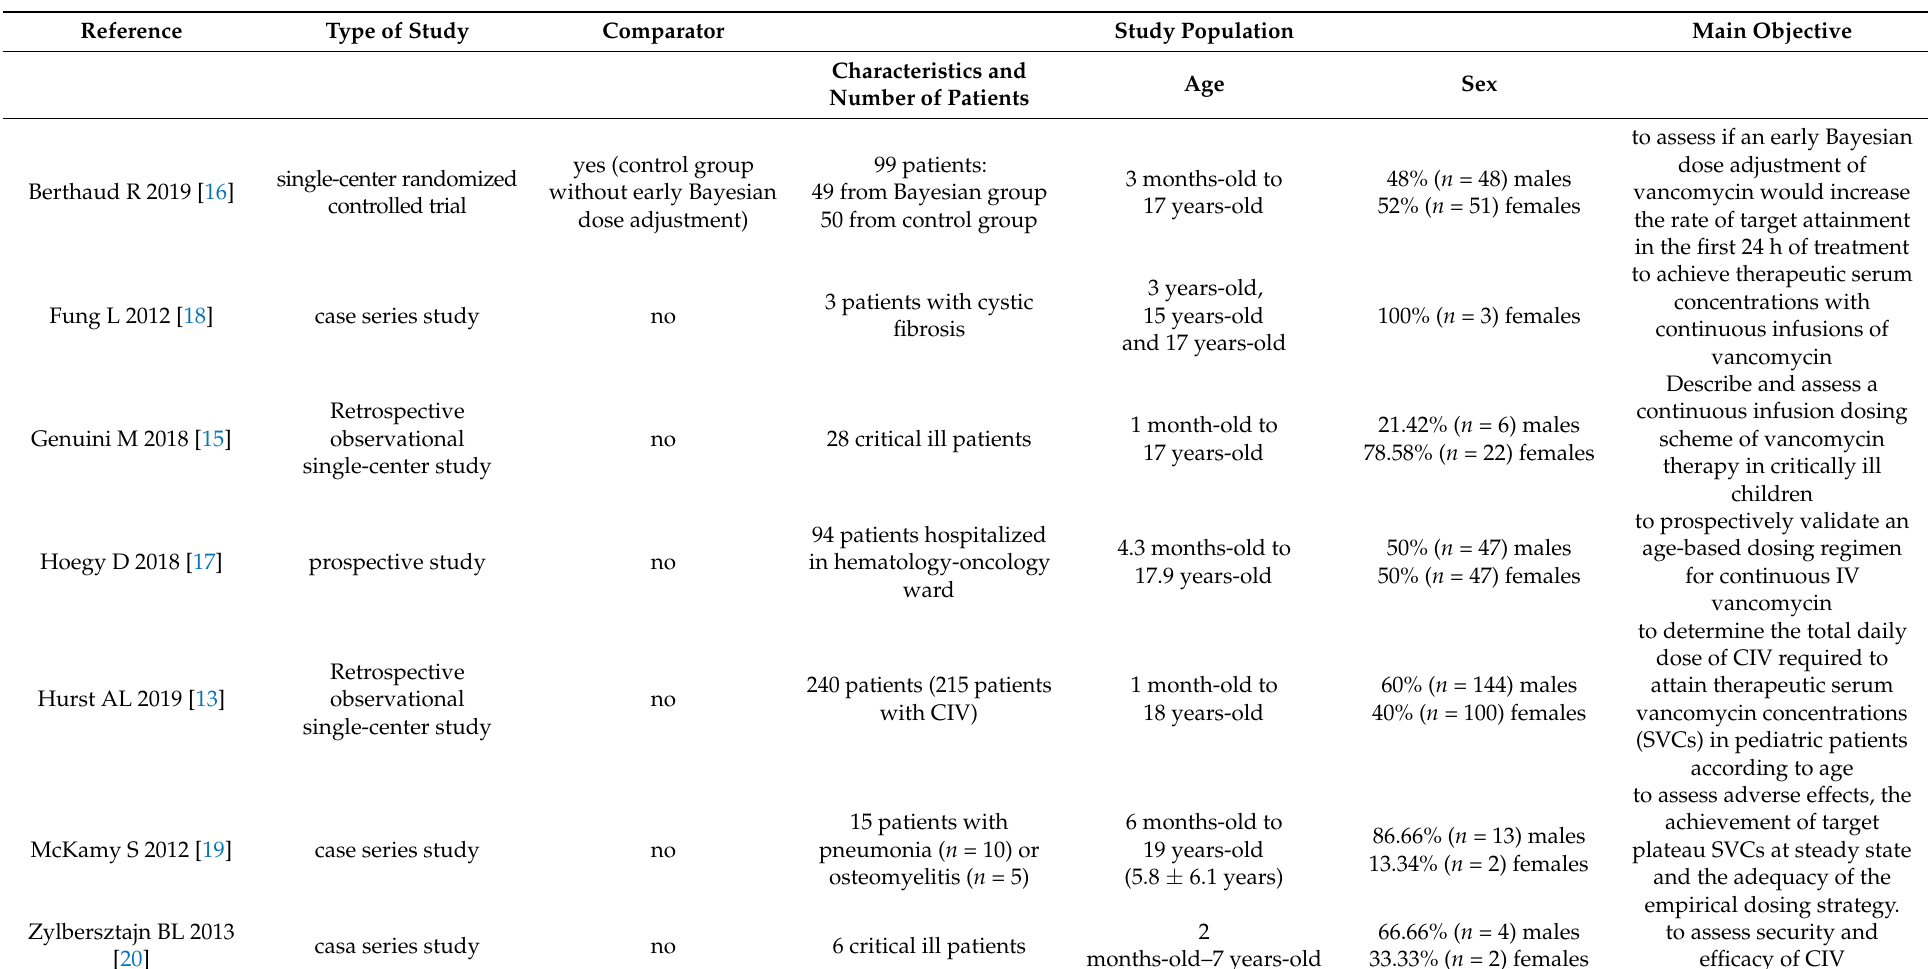
Table 2. Design and study